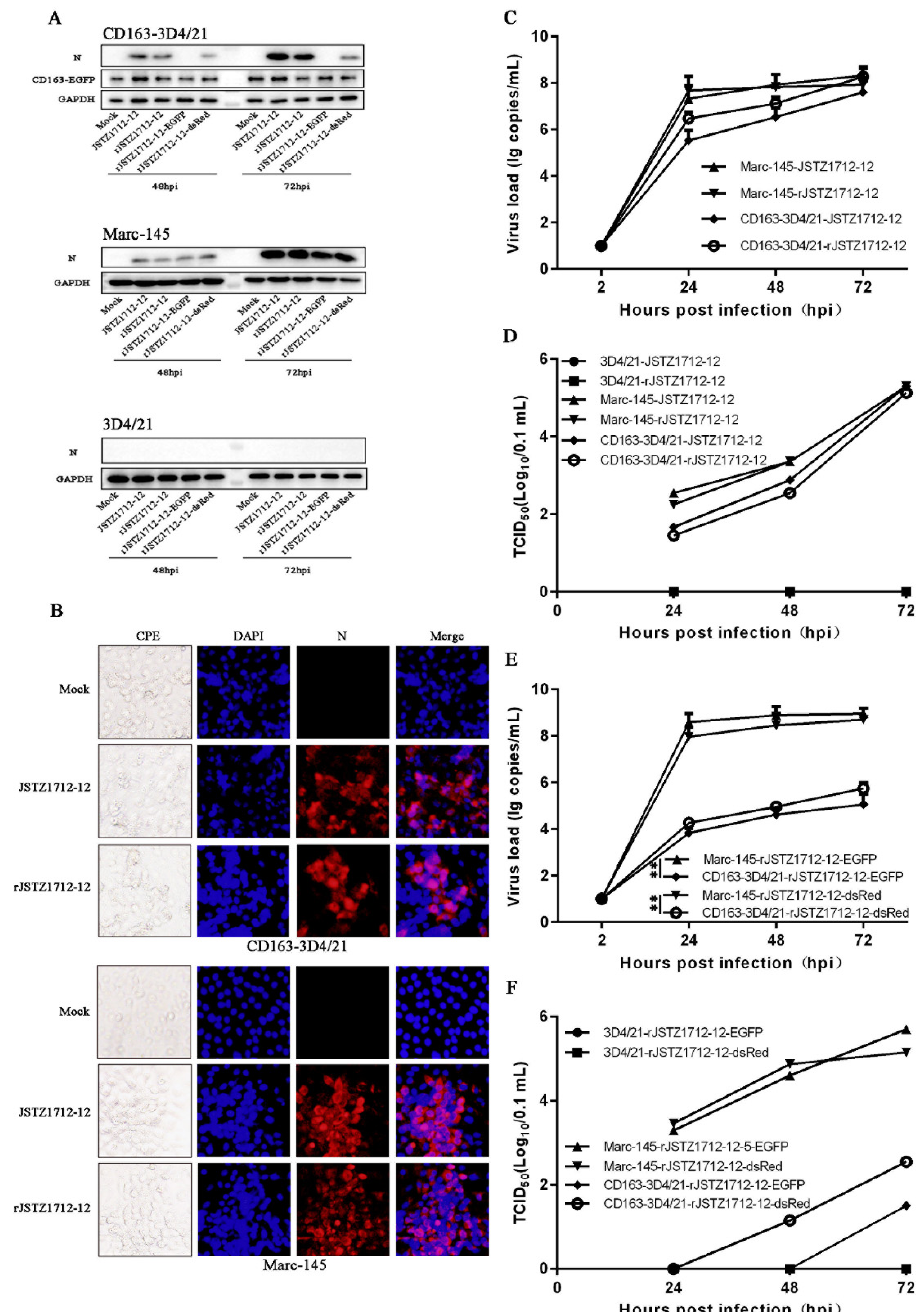
Figure 2. Growth of HP-PRRSV2 avirulent strain JSTZ1712-12 (lineage 8) on 3D4/21 cells stably expressing porcine CD163. ( A ) The CD163-3D4/21 cells, MARC-145 cells, and 3D4/21 cells seeded in 24-well plates were infected with PRRSV JSTZ1712-12 and infectious cDNA clones (rJSTZ1712-12, rJSTZ1712-12-EGFP, or rJSTZ1712-12-dsRed) at an MOI of 0.1, for 48 and 72 h, respectively, followed by Western blotting. ( B ) CD163-3D4/21 cells and MARC-145 cells were infected with PRRSV JSTZ1712-12 and rJSTZ1712-12 at an MOI of 0.1, respectively. The infected cells were observed for CPE and fixed at 48 hpi for IFA using PRRSV N mouse mAb (15A1). ( C – F ) Replication of PRRSV JSTZ1712-12 and infectious cDNA clones (rJSTZ1712-12, rJSTZ1712-12-EGFP, or rJSTZ1712-12-dsRed) in CD163-3D4/21 cells, MARC-145 cells, or 3D4/21cells. The ORF7 transcriptions and virus titers of PRRSV JSTZ1712-12 and infectious cDNA clones within 72 hpi were determined by SYBR Green real-time RT-PCR ( C , E ) and TCID50 assay ( D , F ), respectively. ** p < 0.01.